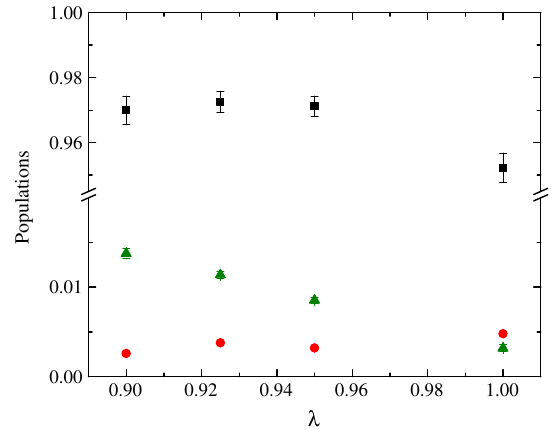
FIG. 13. Scaling factor optimization. Populations of the 52 c (black), 52 e 1 (red), and 52 e 2 (green) states obtained after optimizing the parameter of the rotation part of the circularization pulse, for different values of the scaling factor λ